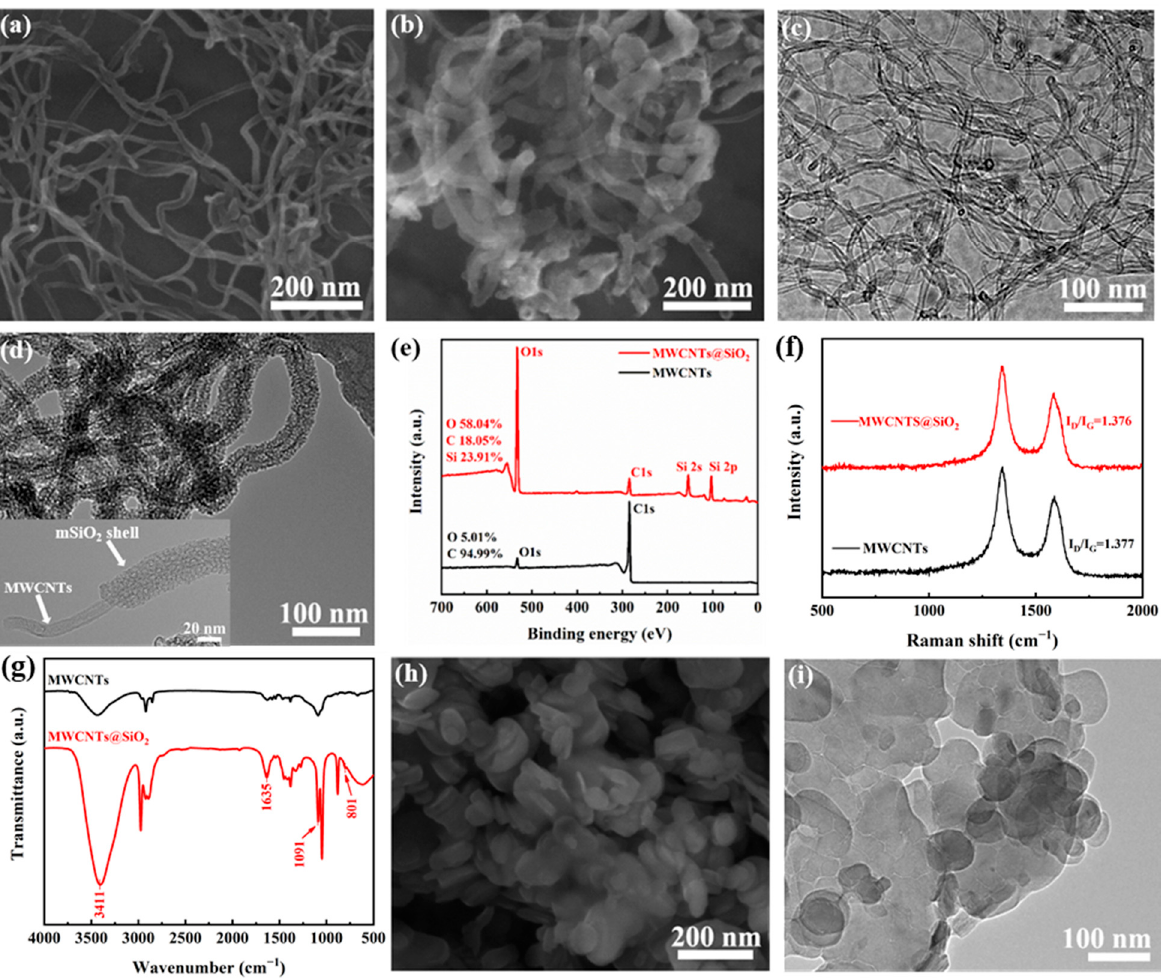
Figure 2. Characterization of MWCNTs and MWCNTs@mSiO 2 . SEM image of ( a ) MWCNTs and ( b ) MWCNTs@mSiO 2 . ( c ) MWCNTs. ( d ) TEM image of MWCNTs@mSiO 2 . Inset is an individual MWCNTs@mSiO 2 . ( e ) FT − IR spectra of MWCNTs and MWCNTs@mSiO 2 . ( f ) XPS general spectra of MWCNTs and MWCNTs@mSiO 2 . ( g ) Raman spectra of MWCNTs and MWCNTs@mSiO 2 . ( h ) SEM image of h-BN. ( i ) TEM image of BNNS.